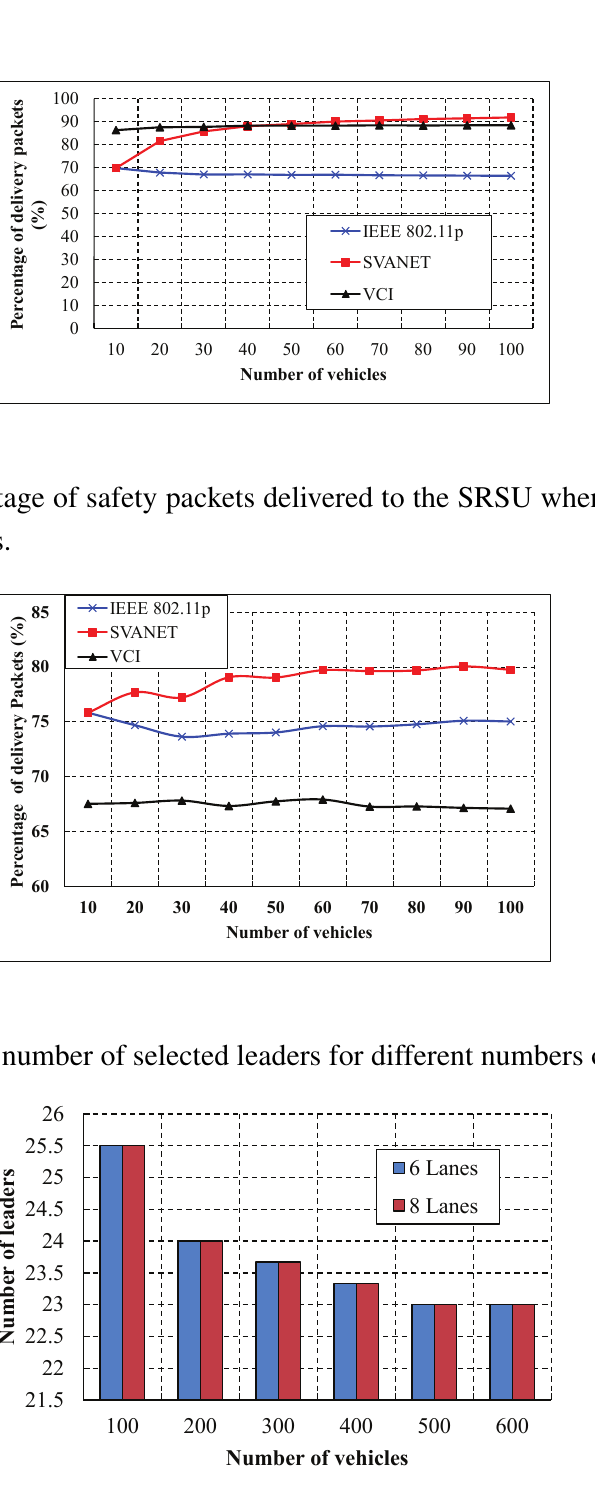
Figure 15. Percentage of safety packets delivered to the SRSU when the CCH interval is > 50 ms.